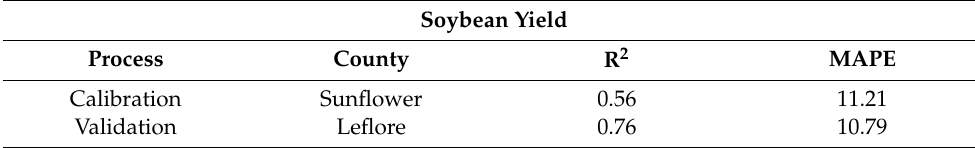
Table 4. Model performance for Soybean yield.